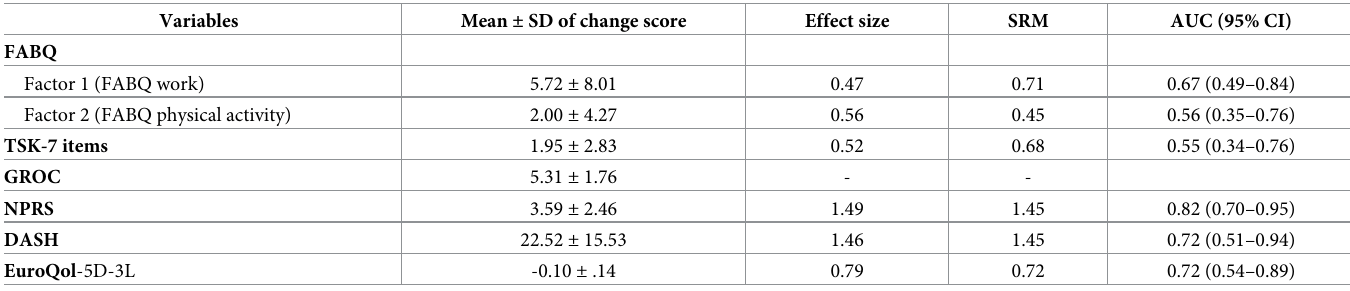
Table 5. Responsiveness of Fear-Avoidance Beliefs Questionnaire and Tampa Scale of Kinesiophobia (n = 59).